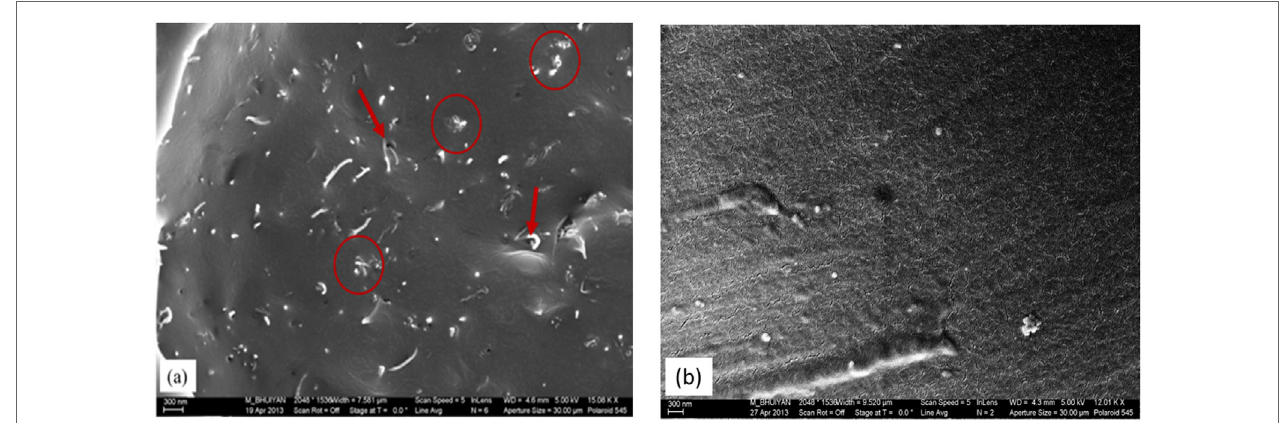
FigUre 5 | seM images of the fracture surface of (a) 4 wt% cnT/PP bulk composites and (B) 3 wt% cnT/PP fiber composites showing the presence of cnT agglomerates (circled) and voids at the cnT/PP interface.